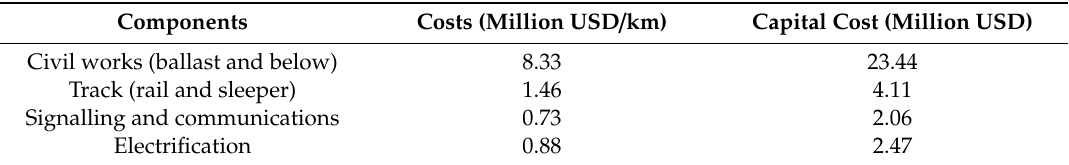
Table 2. Railway cost.